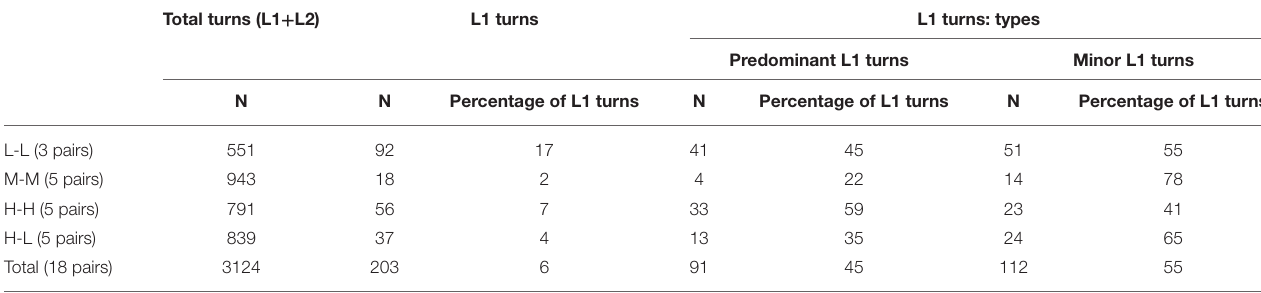
TABLE 6 | The frequency and type of L1 turns per proficiency pairing.